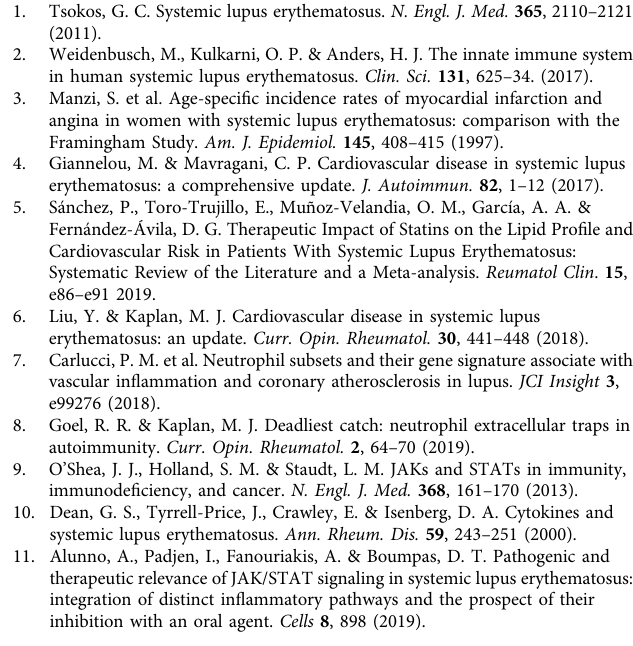
used where appropriate. No adjustments were made for